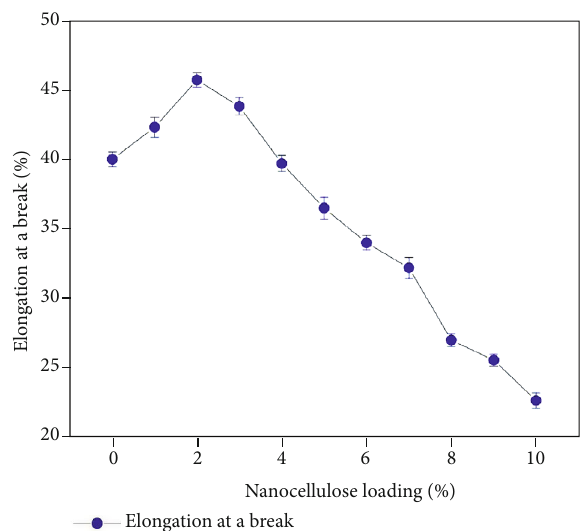
Figure 2: Elongation at break of PVA and PVA-NC composite fi